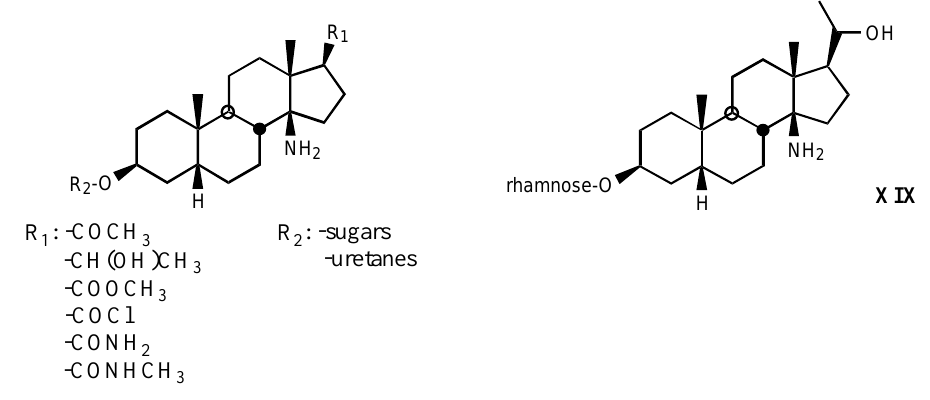
Figure 19. Structure of some 14 b -aminopregnane derivatives.